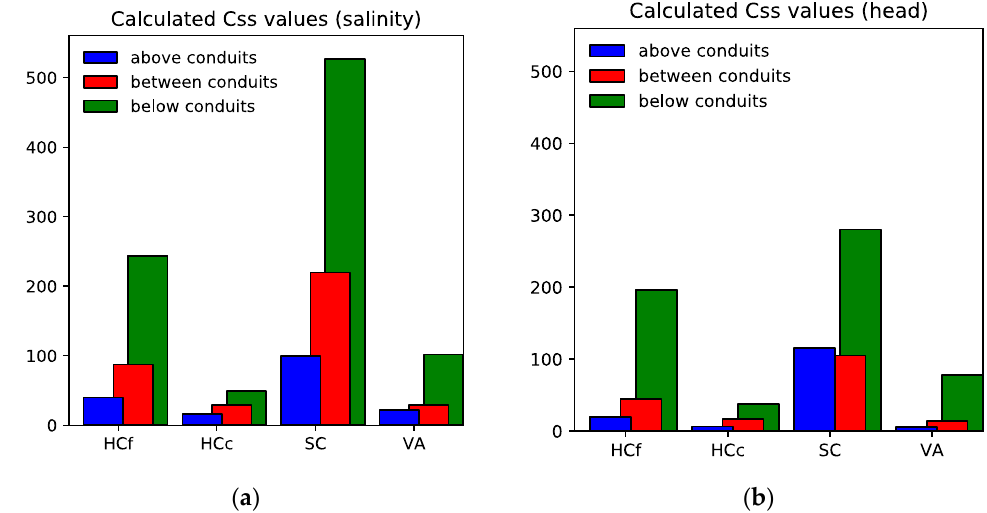
Figure 5. Calculated Css values of all parameters with respect to: ( a ) Salinity simulations in the fractured medium (layer n. 6, 13, 21) and row 16; ( b ) Head simulations in the fractured medium (layer n. 6, 13, 21) and row 16.